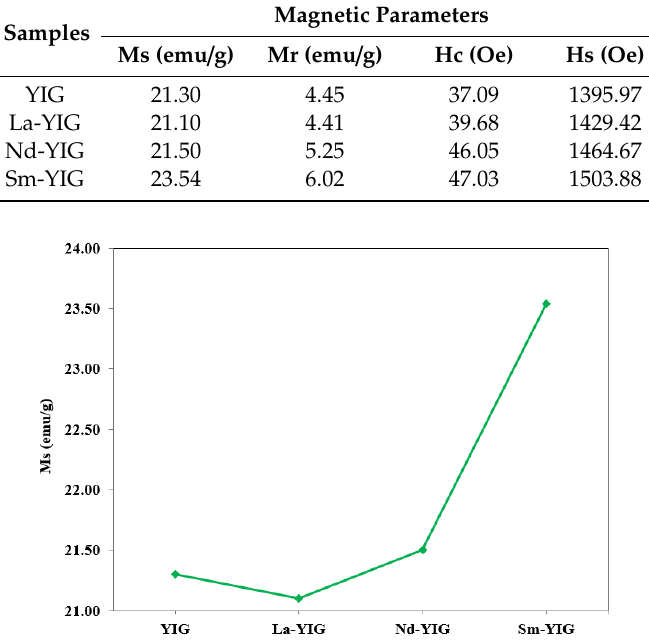
Figure 4. Variation of magnetic saturation with RE-YIG samples.